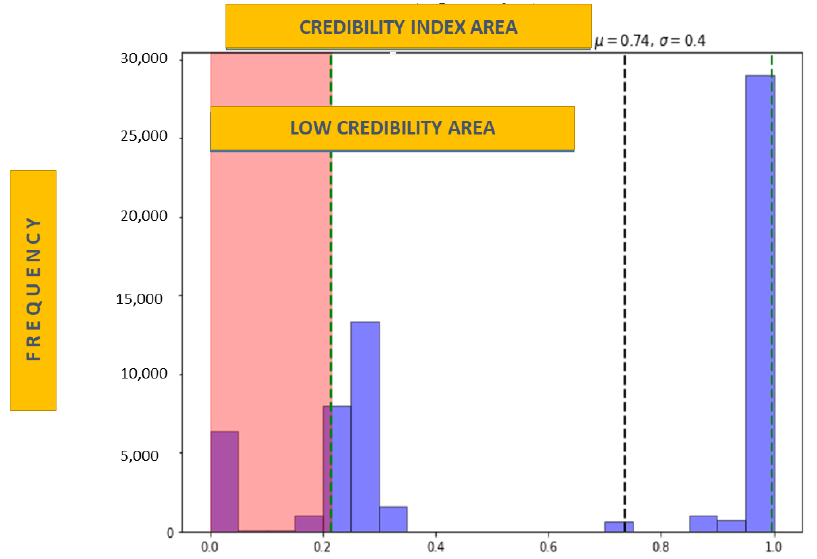
Figure 11. Credibility Index